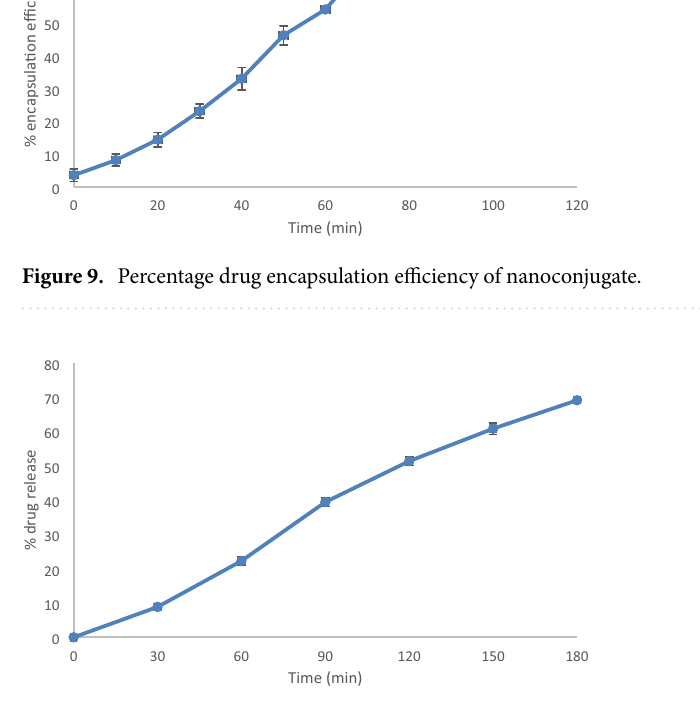
Figure 10. Percentage drug release efficiency of